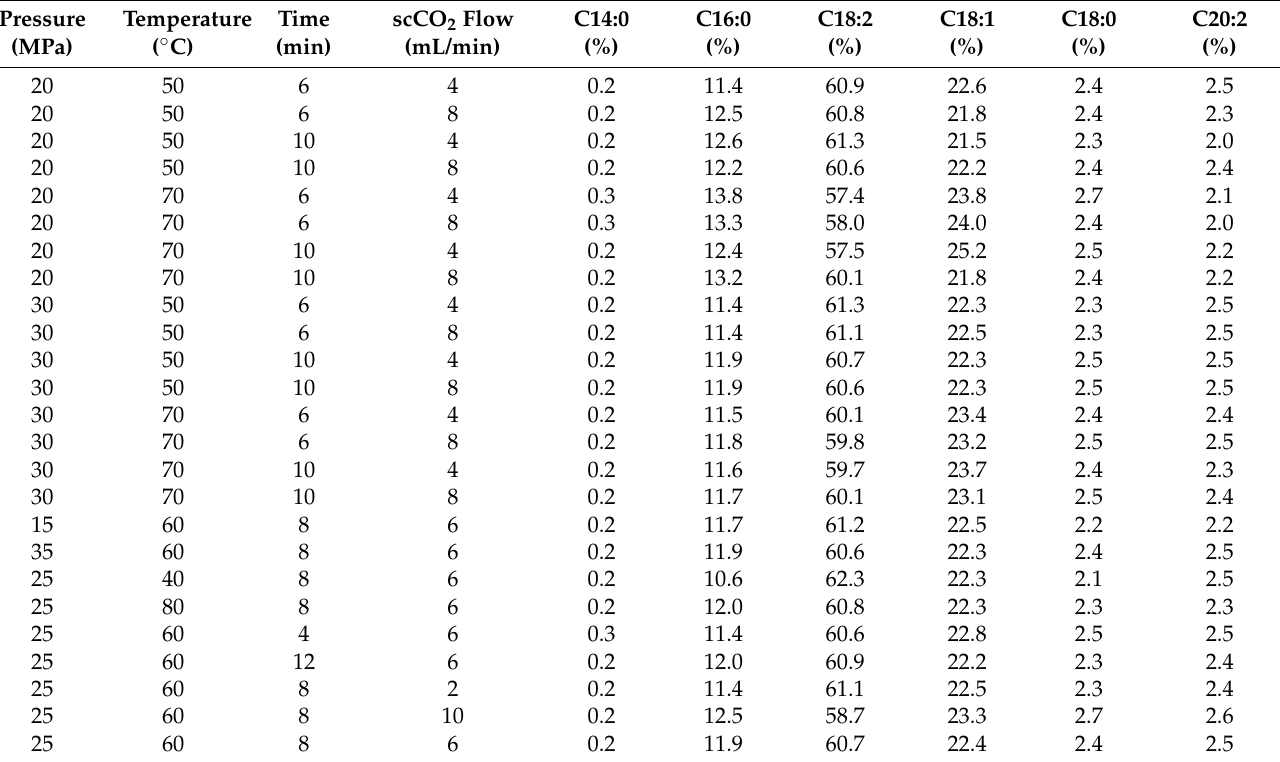
Table 4. Contributions of myristic (C:14), palmitic (C16:0), linoleic (C18:2), oleic (C18:1), stearic (C18:0) and eicosadienoic acids (C20:2) in the total of fatty acids in the NS seed oils obtained at different conditions of scCO 2 pressure, scCO 2 temperature, extraction time and flow of scCO 2 (results of FAME analysis by